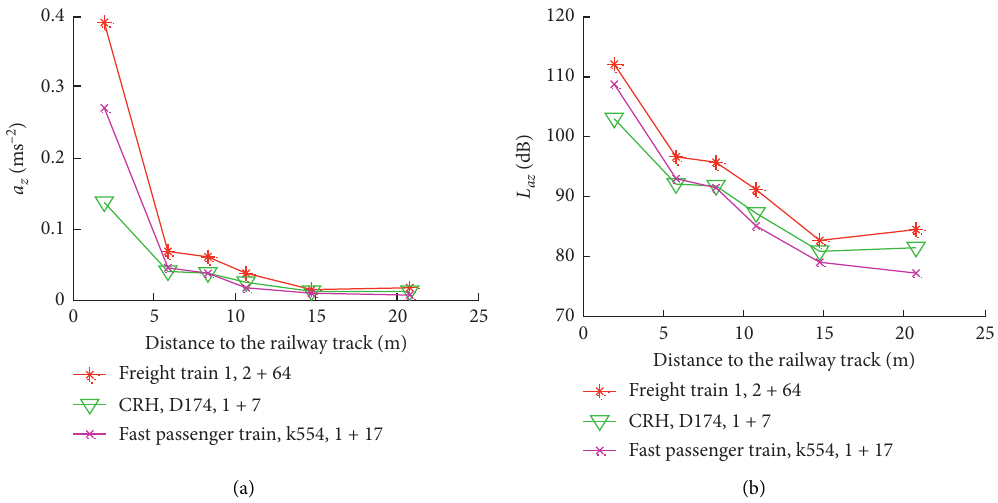
Figure 7: Attenuation mechanism of the vibration response for different train types: (a) vibration acceleration and (b) vibration level.